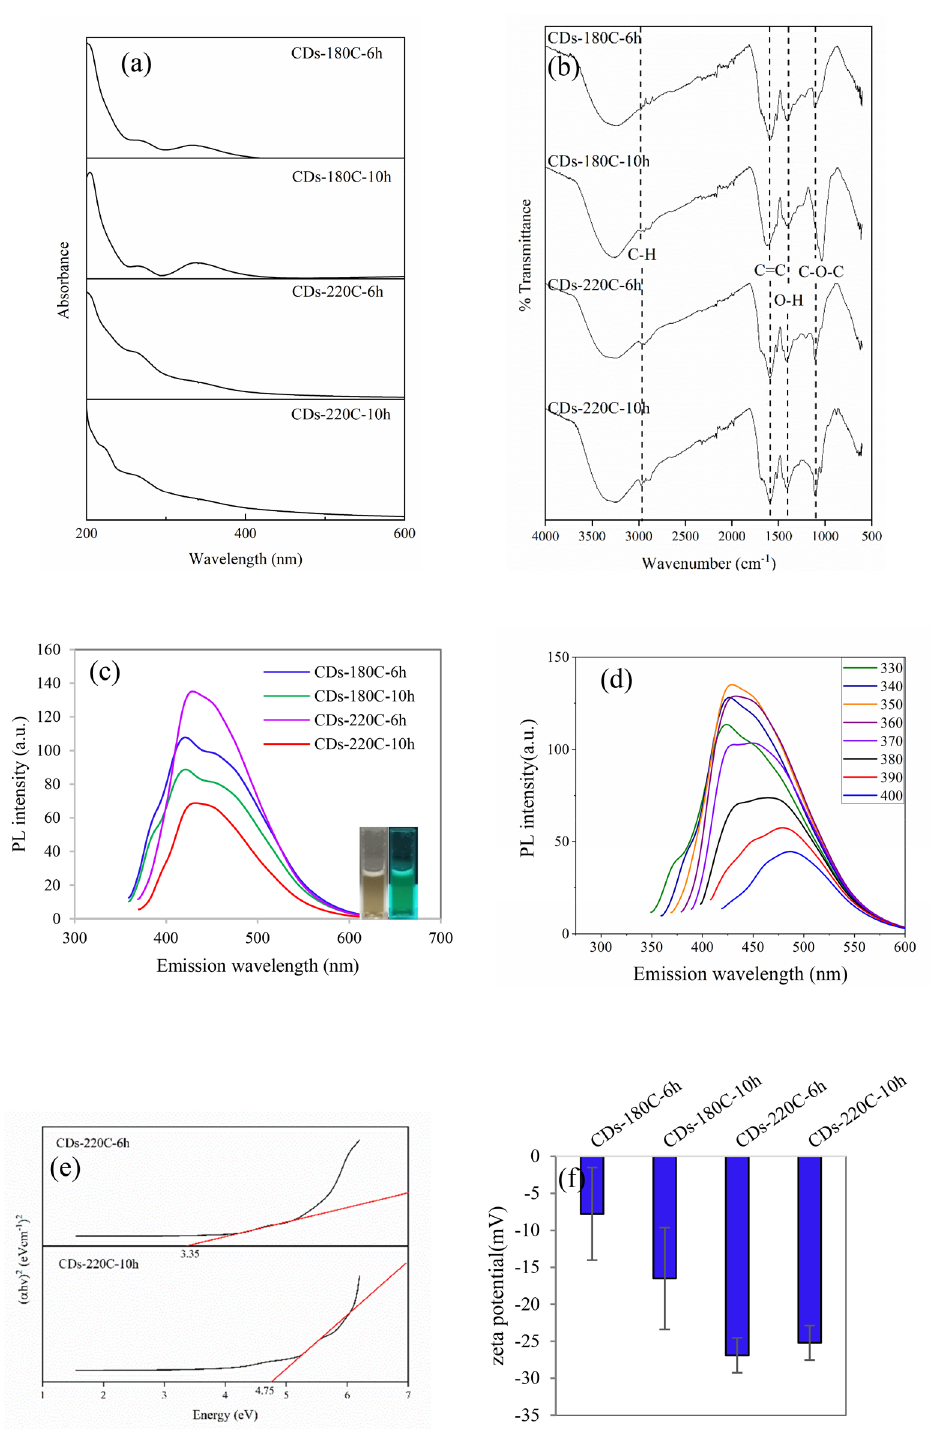
Figure 1. ( a ) UV-Vis spectra of CDs samples, ( b ) The FT-IR spectra of CDs samples, ( c ) Fluorescence emission spectra when the excitation wavelength was 340 nm for CDs-180C and 350 nm for CDs-220C. The upper-left corner inset shows image of CDs solution under daylights (left) and excited via UV light lamp (right), ( d ) PL spectra of CDs-220C-6h, ( e ) Energy band gap of CDs-220C, and ( f ) zeta potential of CDs synthesized from hydrothermal method at different temperatures and